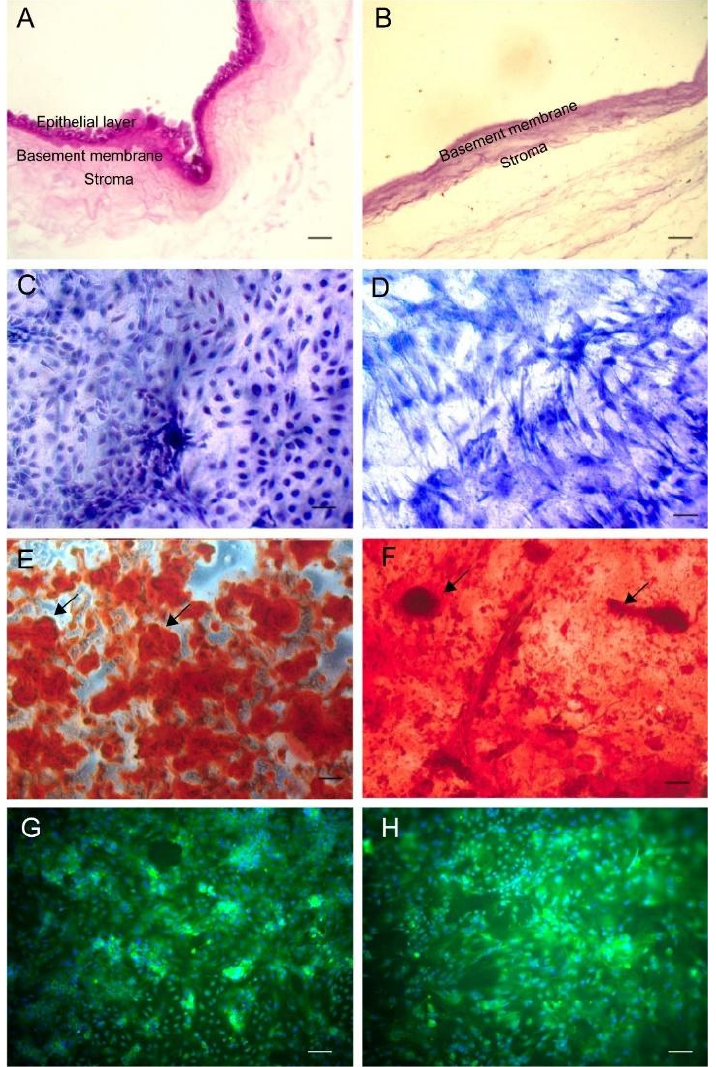
Figure 1. Amniotic membrane histological cross-sections of the intact amniotic membrane with epithelial cell layer (arrow, ( A )) and after decellularization with 0.1% Sodium Dodecyl Sulphate as a collagenous scaffold ( B ). Representative areas of adipose-derived stromal cell (ASCs) cultures on polystyrene ( C , E , G ) and decellularized amniotic membrane (DAM) ( D , F , H ). ASCs confluence in the presence of supplemented medium ( C , D ). The osteoinduction medium stimulated the deposition of the mineralized extracellular matrix observed as red calcified deposits (arrows). Osteopontin expression was evidenced by green fluorescence, as agglomerates on polystyrene ( G ), and a diffuse distribution on DAM (H). H&E stain ( A , B ); Giemsa stain ( C , D ); Alizarin red stain (pH 5.5) ( E , F ); green-fluorescent Alexa Fluor 488, Hoechst blue-fluorescent nuclear staining ( G , H ); objectives × 20 ( A – H ); scale bars 100 μ m ( A – H ).